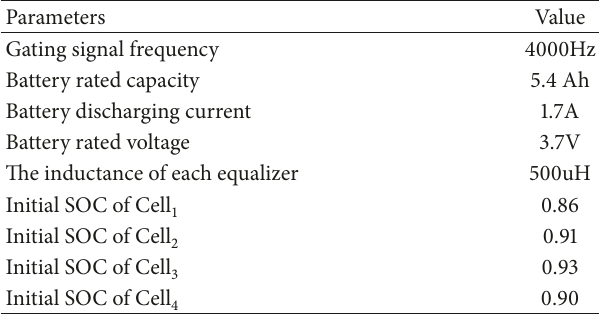
Table 2: Simulation parameters of four-cell battery